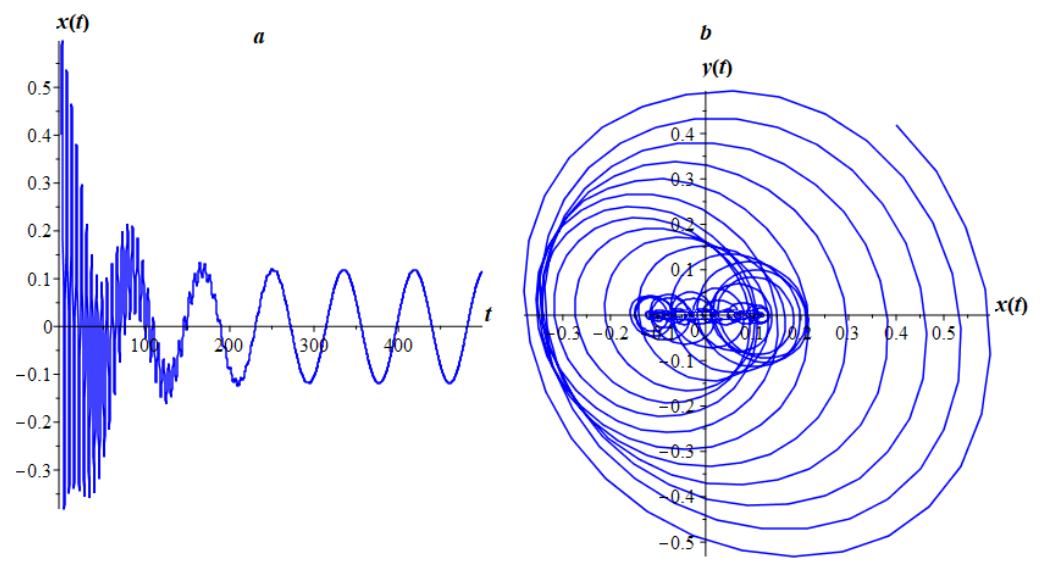
Figure 1. Oscillogram ( a ) and phase trajectory ( b